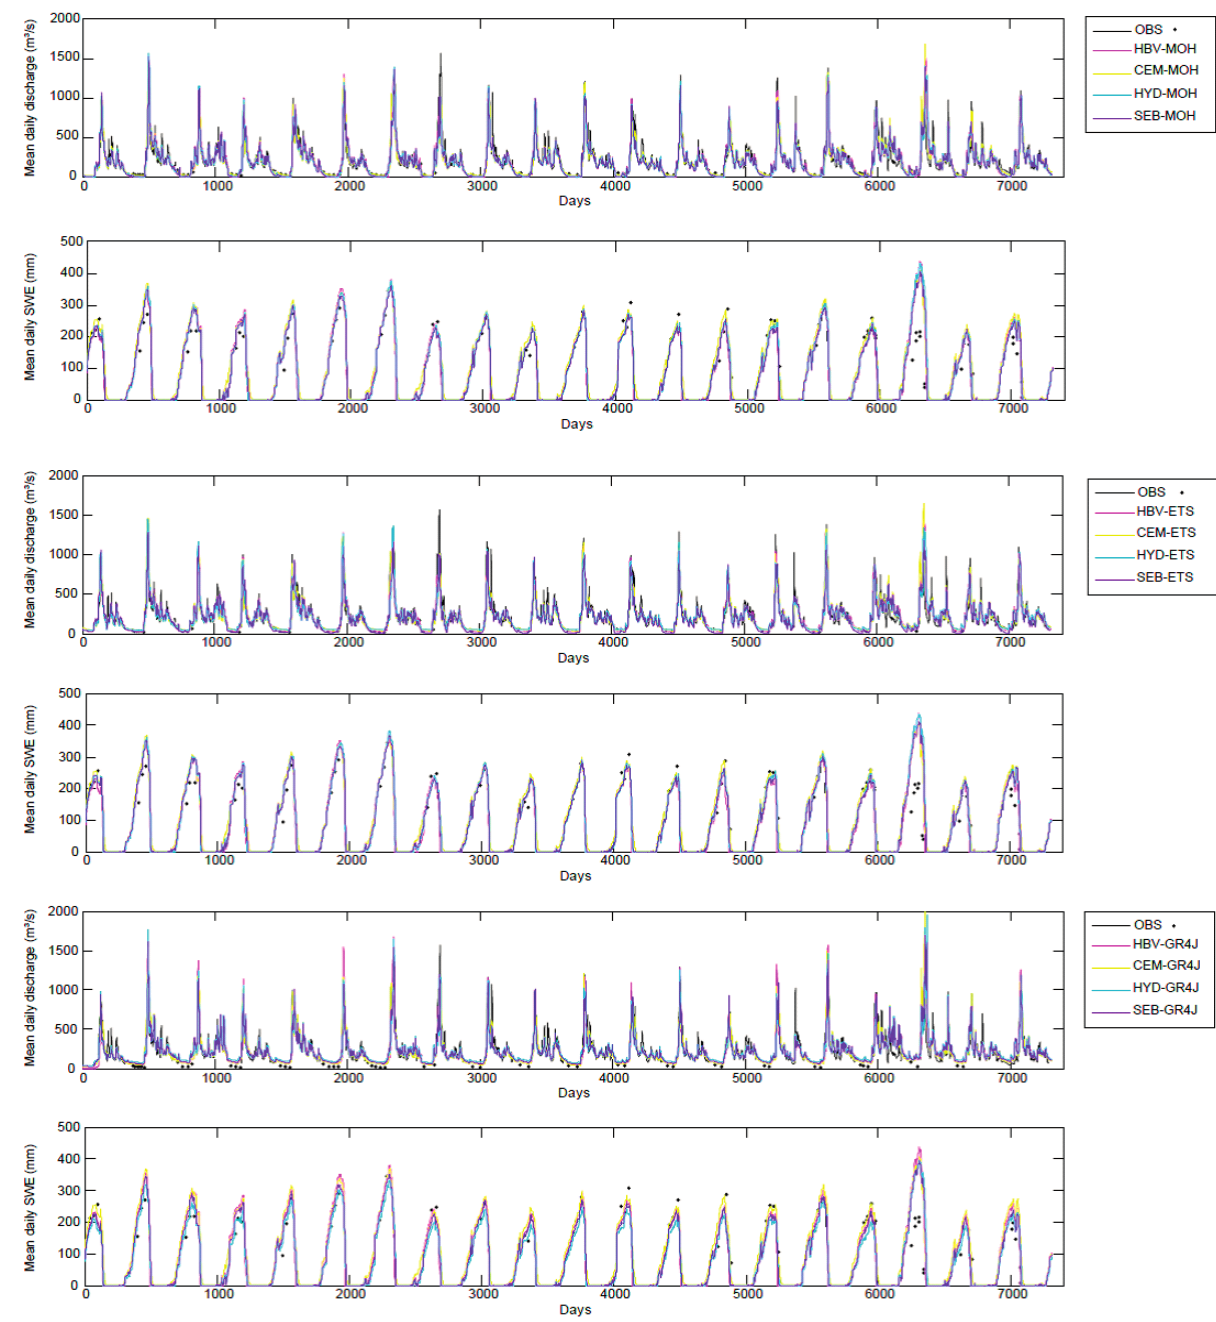
Figure 6. Annual hydrographs of observed (OBS), simulated discharges and SWEs using the 12 SM-HM combinations over the calibration period (even years over